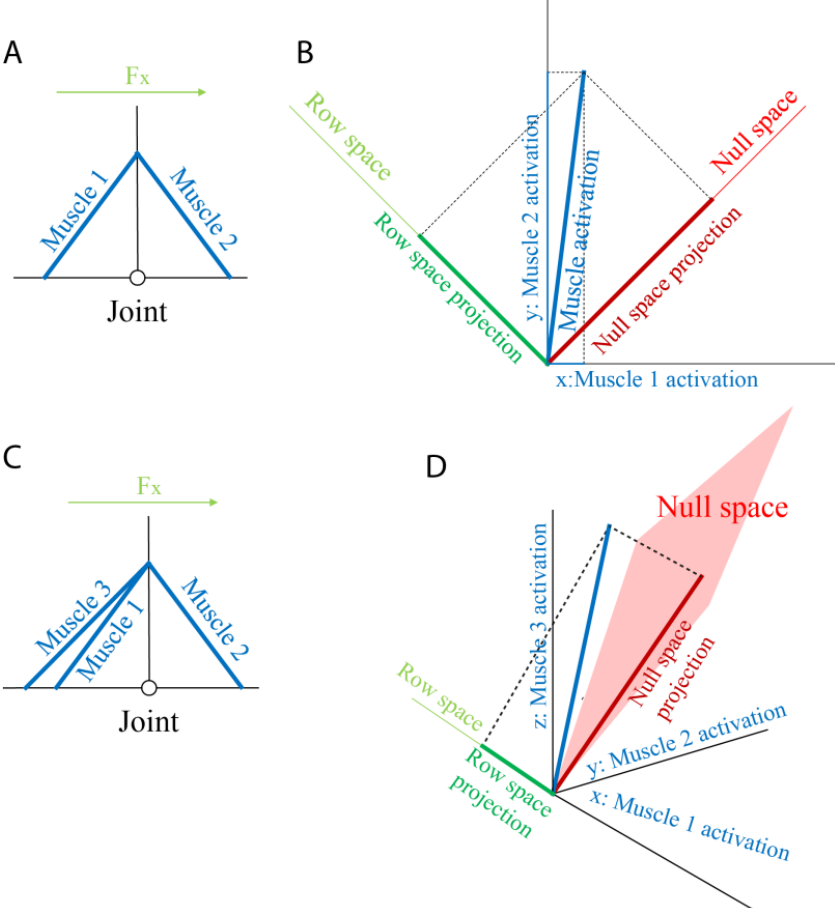
Figure 8. Example of the identification of the projection of the muscle activation onto the row and the null spaces. ( A ) A model made of one joint and two identical antagonist muscles (Muscle 1 and Muscle 2, blue lines). The positive direction of the force is represented as a green arrow (Fx). ( B ) The two-dimensional muscle space whose axes represent the activations of the two muscles (Muscle 1 and Muscle 2 on the x- and y-axis, respectively). The null (red line) and row (green line) one-dimensional subspaces are identified. An example of a muscle activation ([0.1 0.8], blue), together with its projections on the null (dark red) and the row (dark green) spaces, is reported. ( C ) A model comprising one joint and three muscles. Two muscles (Muscle 1 and Muscle 2, blue lines) are antagonist to a third one (Muscle 3). The positive direction of the force is represented by a green arrow (Fx). ( D ) The three-dimensional muscle space whose axes represent the activations of the three muscles (Muscle 1 on the x-axis, Muscle 2 on the y-axis, and Muscle 3 on the z-axis). The null (red plane) and row (green line) subspaces are identified. An example of a muscle activation ([0.1 0.4 0.8], blue), together with its projections on the null (dark red) and the row (dark green) spaces, is